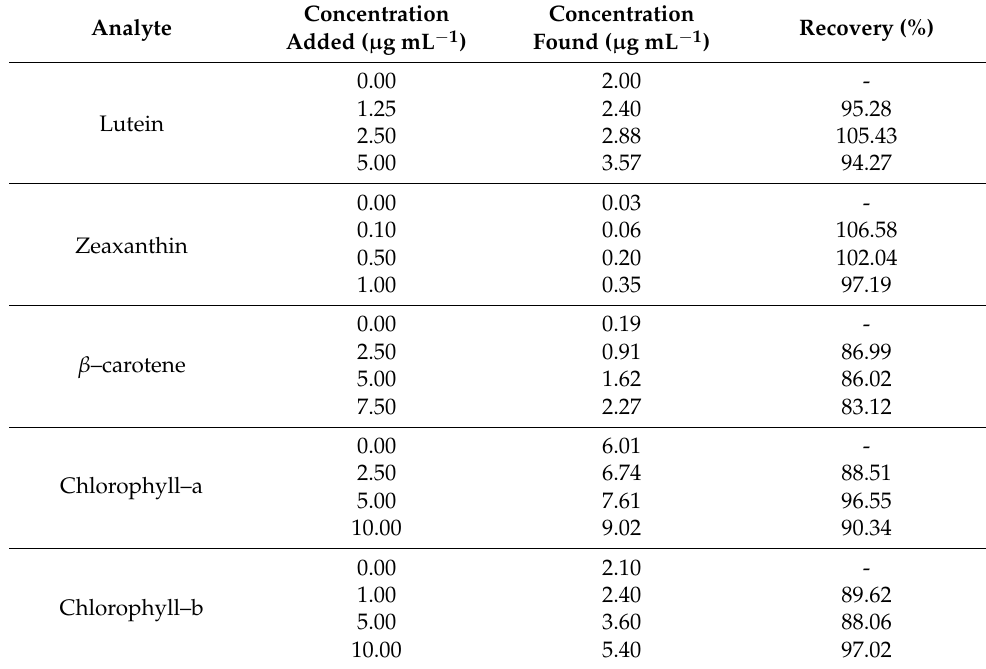
Table 2. Recovery of analytes obtained in samples by the HPLC-UV method